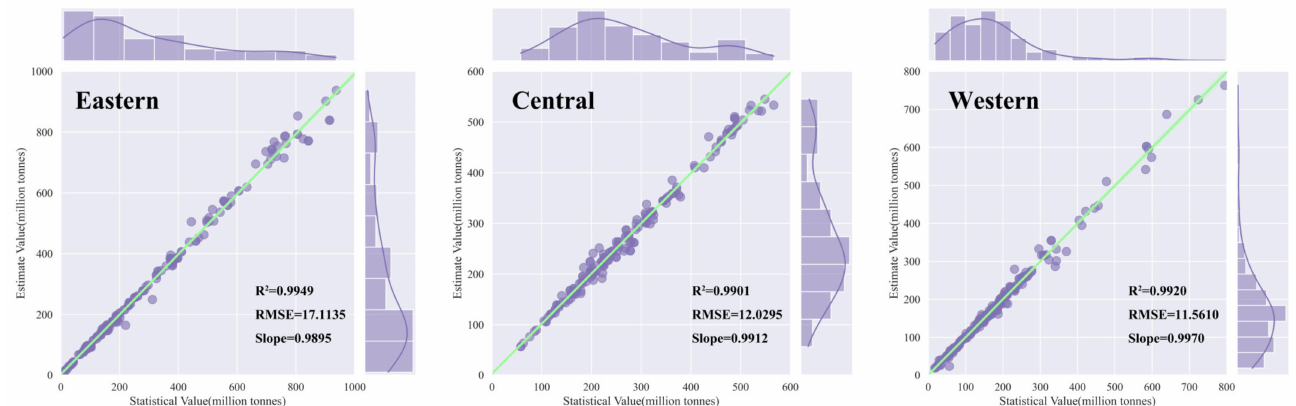
Figure 5. Histograms, scatter plots, and linear fitting lines of estimated and statistical values in the three